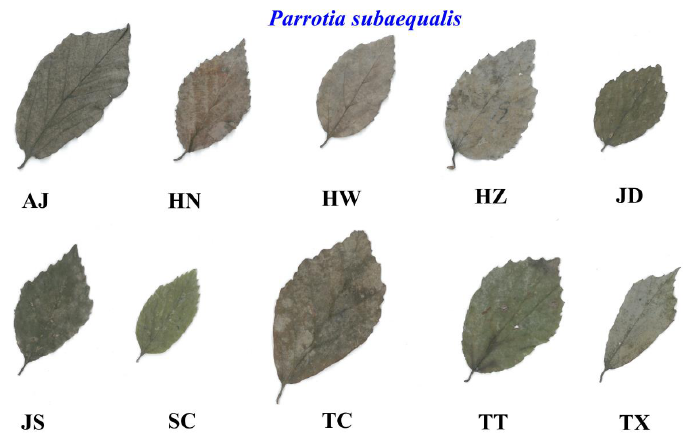
Figure 3. Leaf examples of 10 geographical populations of Parrotia subaequalis in eastern China. The letters below the leaf photos represent the codes of the geographical populations. AJ: Anji, Zhejiang